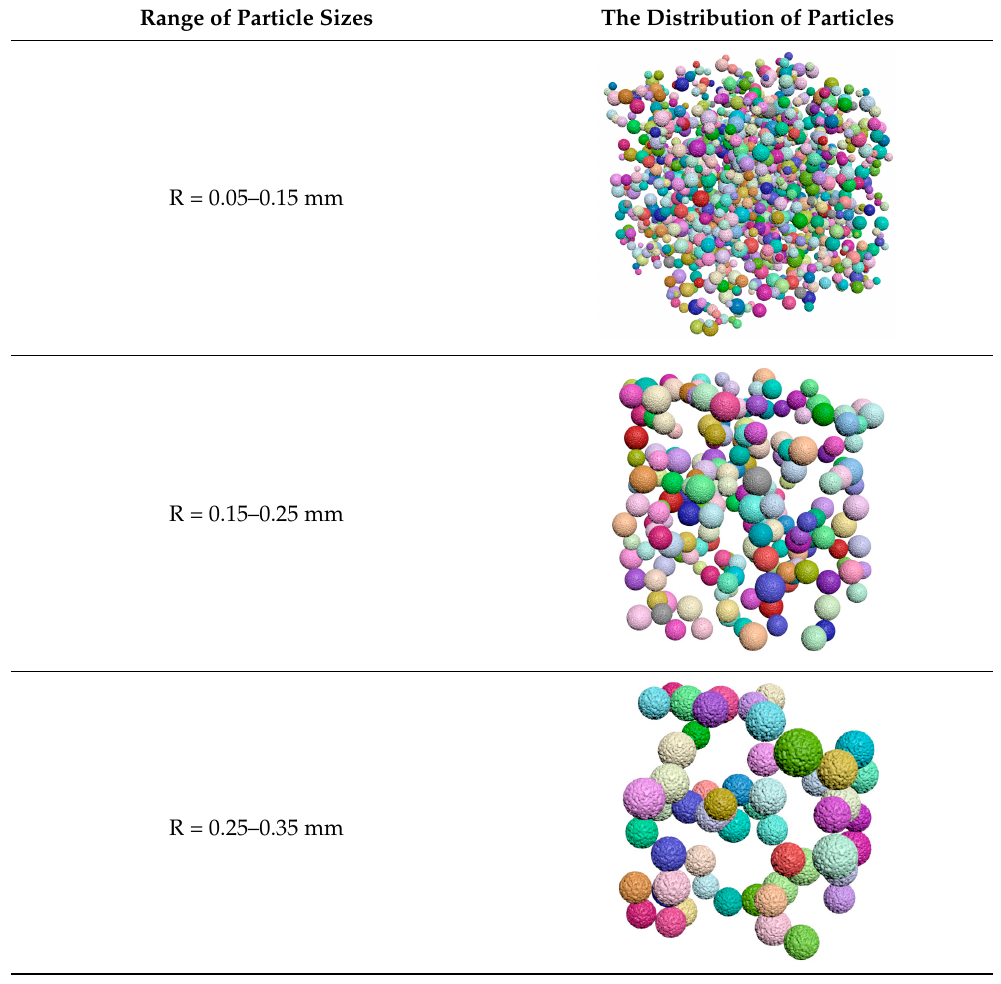
Table 1. Distribution effects of particles with different size ranges with the same probability density. Range of Particle Sizes